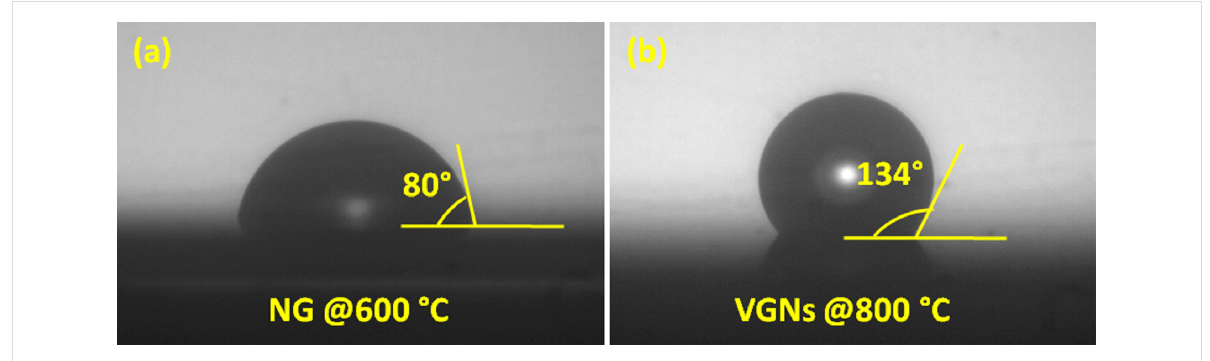
Figure 9: Water contact angle for the (a) nanographitic film (NG), grown at 600 °C and (b) VGNs, grown at 800 °C.